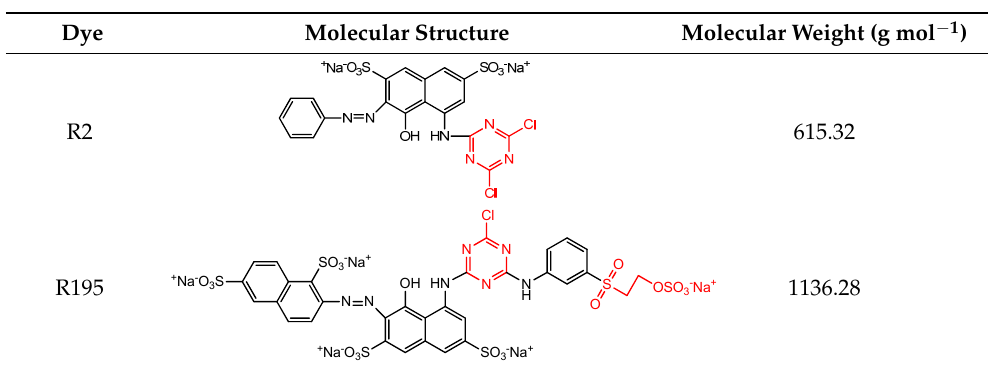
Table 1. Reactive dye structures and molecular weights [16,17].